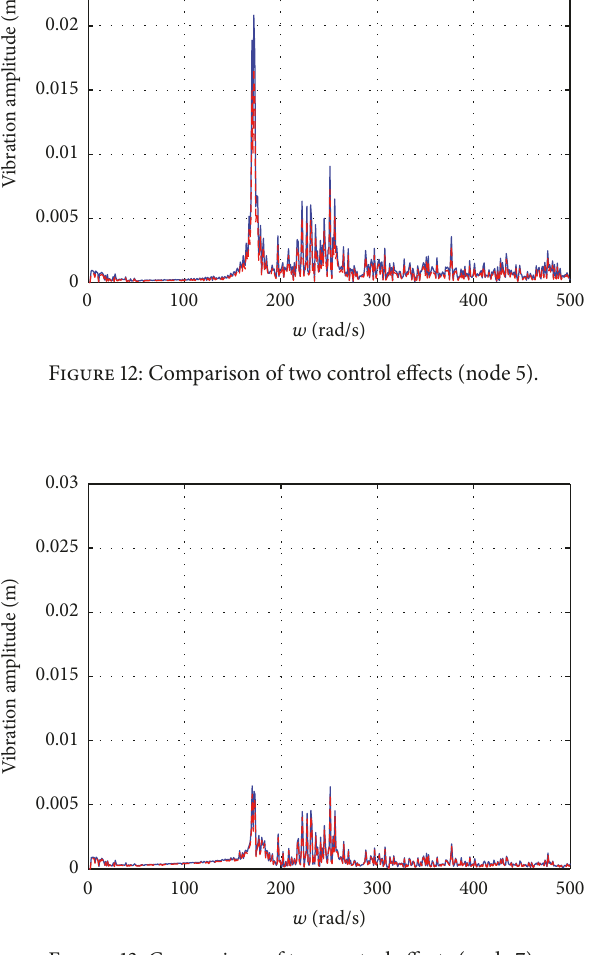
Figure 13: Comparison of two control effects (node 7).